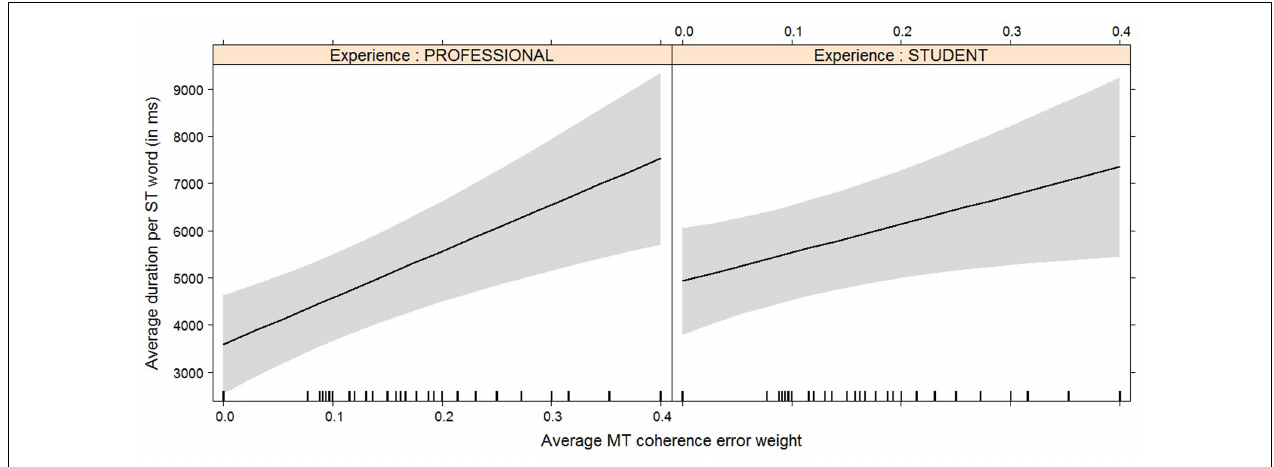
FIGURE 8 | Effect plot of MT coherence error weight on average duration. An increase in average MT coherence error weight leads to an increase in the average duration. Students have a higher overall average duration, but the average duration increases somewhat more rapidly for professionals with an increase of MT coherence error weight than it does for